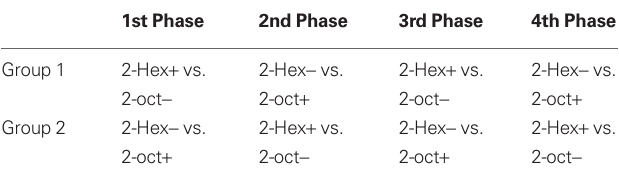
Table 1 | Two independent groups of bees were trained along four consecutive olfactory reversal discriminations, using 2-hexanol (2-Hex) and 2-octanone (2-Oct) as odorants to be discriminated. The contingencies ( + : reinforced with sucrose solution; – : non-reinforced) of the odorants were varied systematically from one phase to the next. Groups were balanced with respect to odorant contingency.